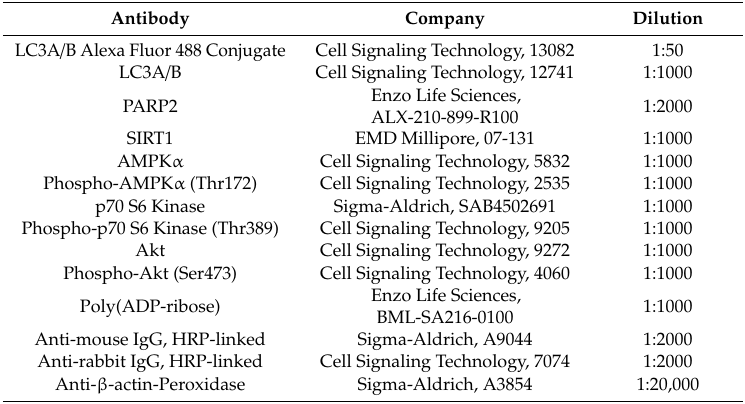
Table 2. Antibodies used in the